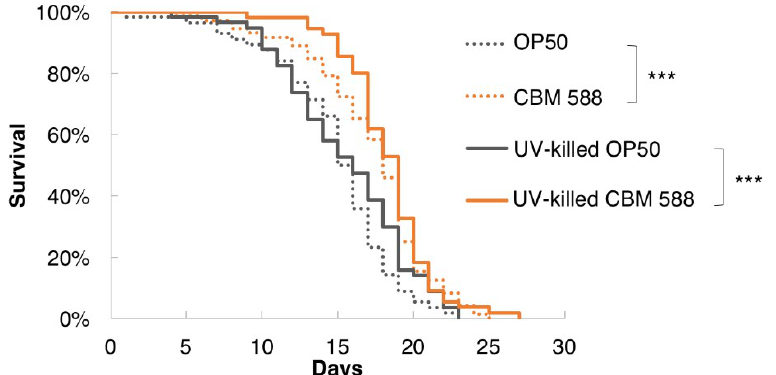
Figure 2. UV-killed CBM 588 prolonged the longevity of C. elegans. Survival curves of animals fed UV-killed bacteria. The lifespan of worms fed UV-killed CBM 588 was significantly increased compared with those fed UV-killed OP50. OP50, n = 56; CBM 588, n = 72; UV-killed OP50, n = 57; UV-killed CBM 588, n = 55. *** p < 0.001, log-rank test. Detailed lifespan data and statistics are provided in Table S7.